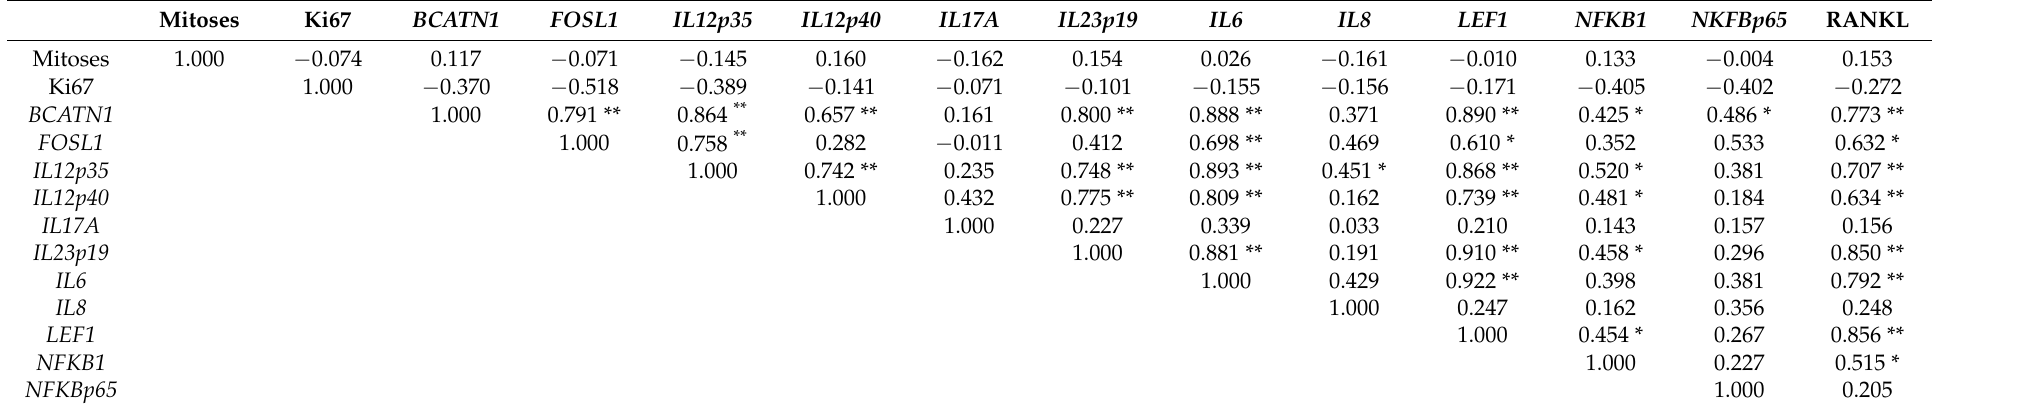
Table 3. Correlation matrix (Spearman rank correlation coefficient, ρ